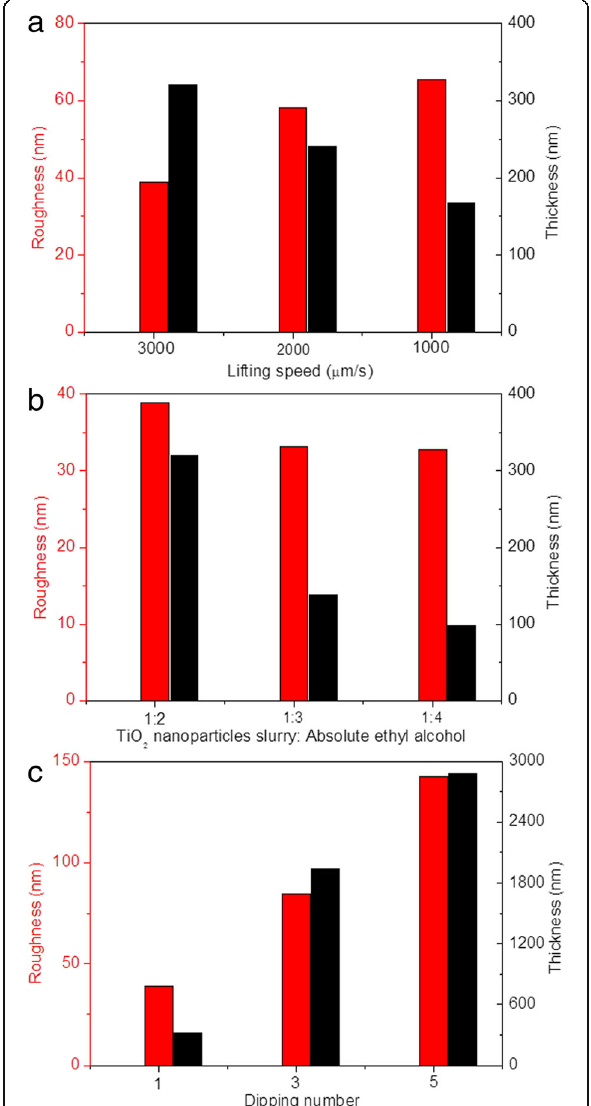
Fig. 6 (Color online) Roughness ( red ) and thickness ( black ) of TiO 2 thin films prepared with a different lifting speeds, b precursor concentrations, and c dipping numbers